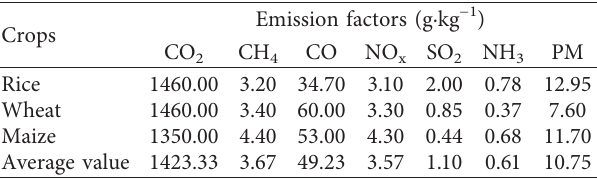
Table 8: Emission factors of straw open